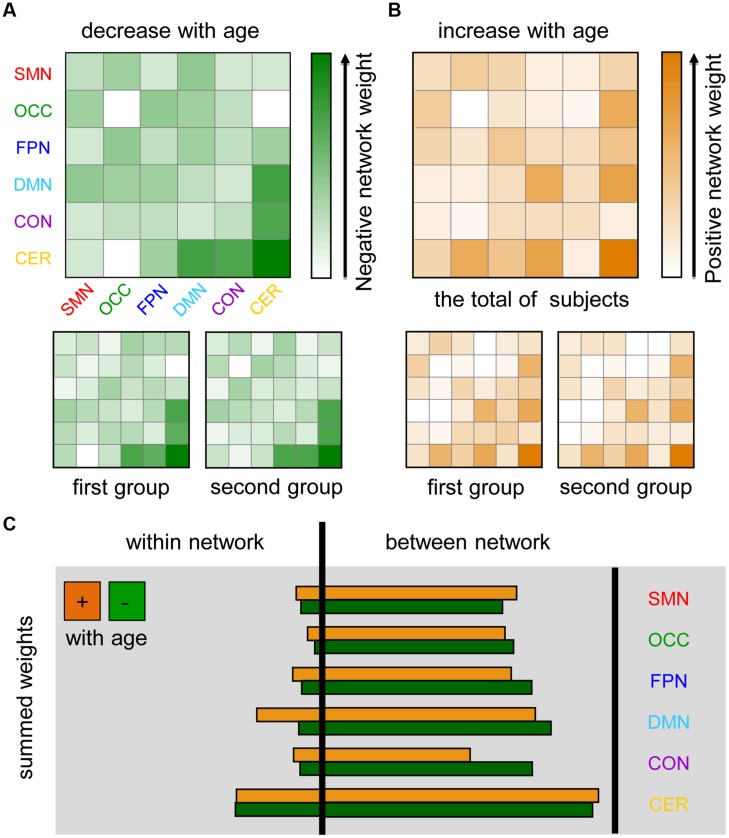
Maturation-related networks in the dynamics of functional connectivity. SMN, sensorimotor network; OCC, occipital network; FPN, fronto-parietal network; DMN, default mode network; CON, cingulo-opercular network; CER, cerebellum. The first group includes 85 subjects with TR = 2500 ms and the second group contains 98 subjects with TR = 645 ms. (A) Negative network weight (1/2 the sum of the bootstrap ratios of connections that decreased with age affiliated with corresponding networks) reflects the “network-distribution” of connections that decrease with age in dynamics. (B) The positive network weight, which was calculated by a similar method, represents the distribution of connections that increase with age. (C) The sum of all of the connection bootstrap ratios within each network and between networks are shown to the left and right of the black line, respectively.